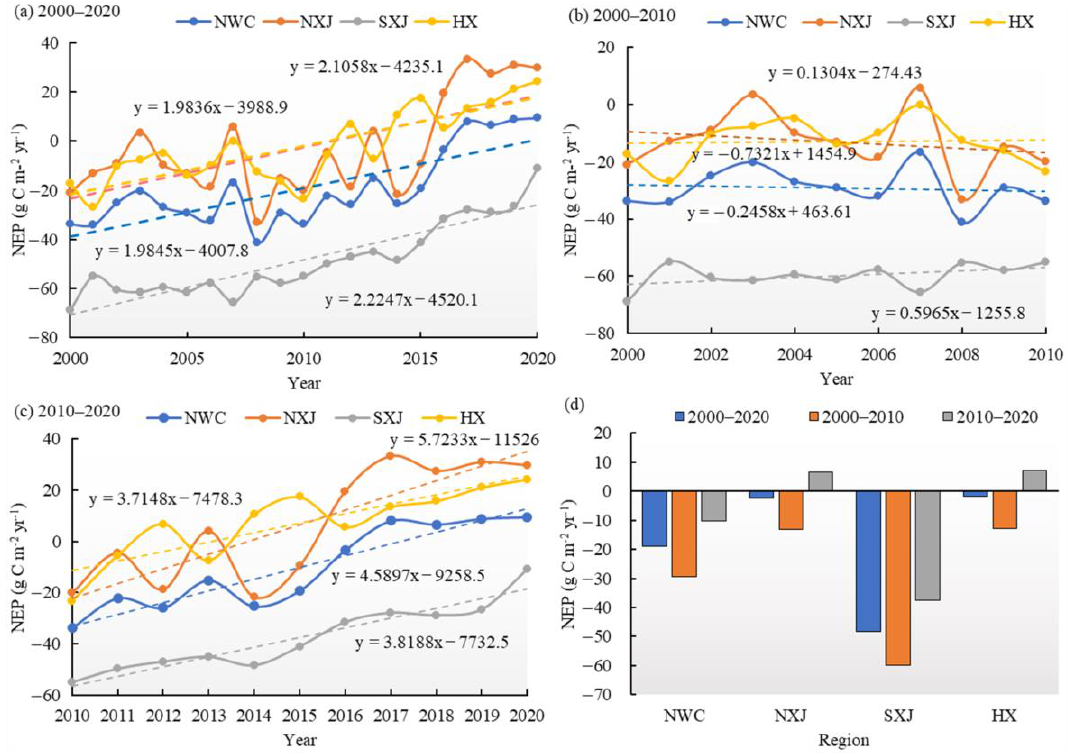
Figure 3. Temporal variations in NEP for different regions of NWC during ( a ) 2000 – 2020, ( b ) 2000 –